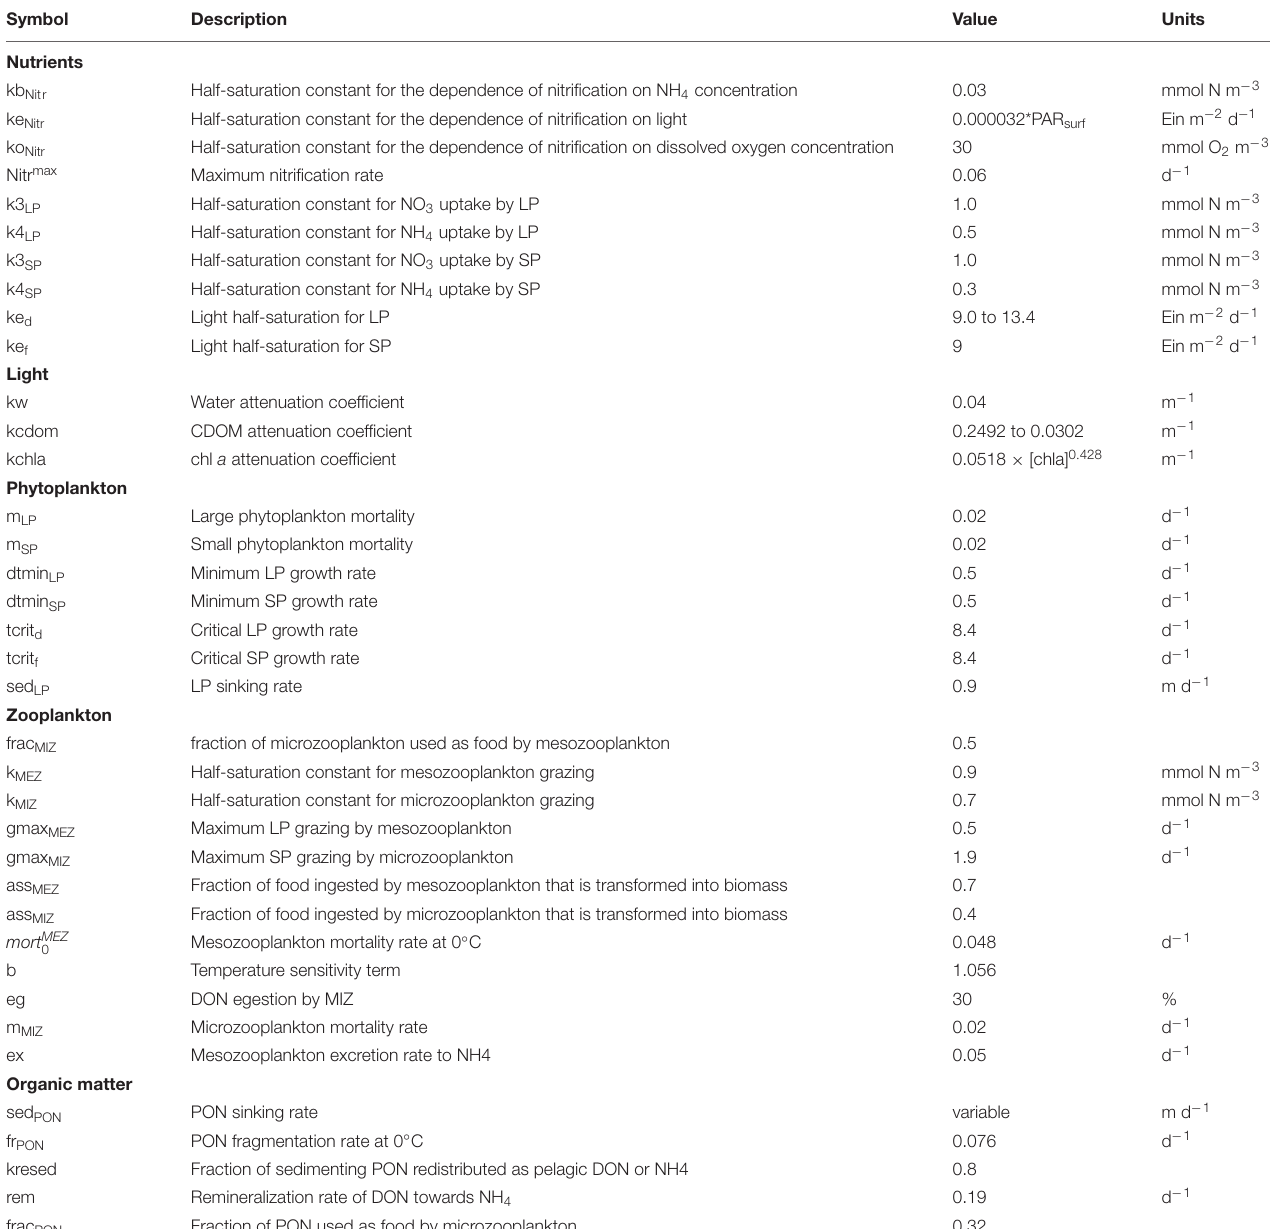
TABLE 1 | Biogeochemical model